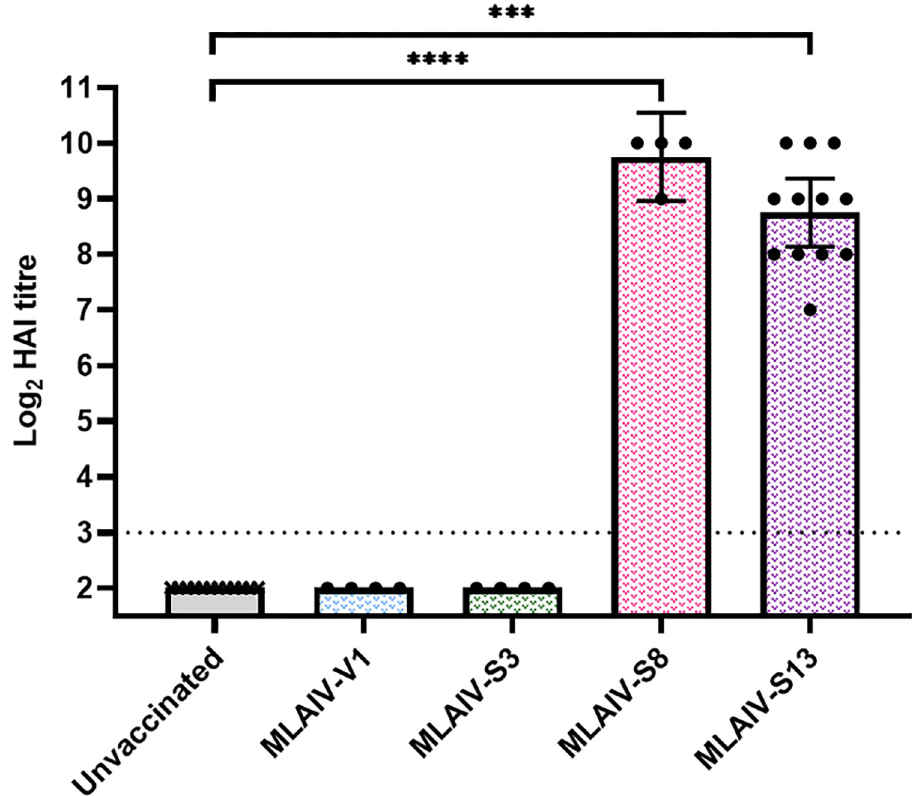
Fig 3. A/SLOV15 S8 and S13 elicited a serum immune response in ferrets, indicating that immunogenicity depends on replicative fitness. A cross-section of A/SLOV15 variants underwent immunogenicity testing in ferrets. Groups of 4–12 ferrets were vaccinated with 4.0 Log 10 FFU of monovalent V1 (MLAIV-V1), monovalent S3 (MLAIV-S3), monovalent S8 (MLAIV-S8) and monovalent S13 (MLAIV-S13). Four unvaccinated ferrets were also included as controls. Serum immune responses were measured by HAI. Antisera were collected 21 days post- vaccination and titrated against parental V1 virus, containing wt A/SLOV15 HA sequence. MLAIV-V1, MLAIV-S3, MLAIV-S8 and MLAIV-S13 HAI titres were compared to the unvaccinated control animals by performing a Kruskal- Wallis test followed by Dunn’s multiple comparisons test. HAI titres for individual animals are depicted by the scatter plots, median values for each vaccination group are indicated by the columns. Error bars show median with 95% CI, and the dotted line represents the lower limit of detection (LLD). Values below the LLD are plotted as ½ LLD for statistical purposes. P values are indicated as follows: ���� P < 0.0001 and ��� P <